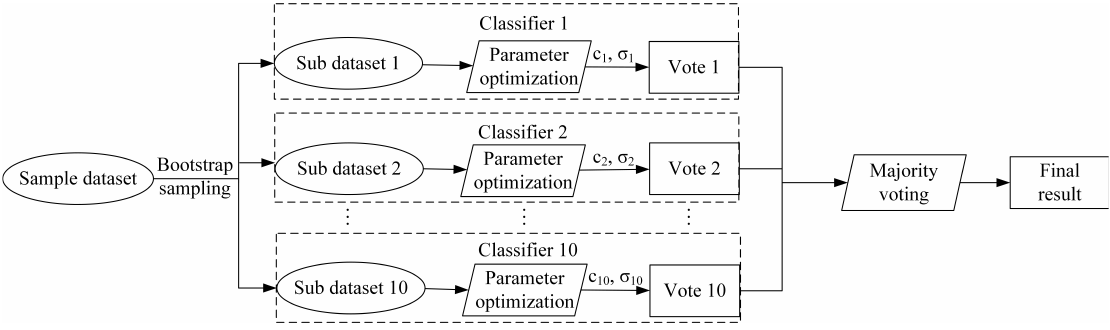
Figure 1. Schematic diagram of the proposed